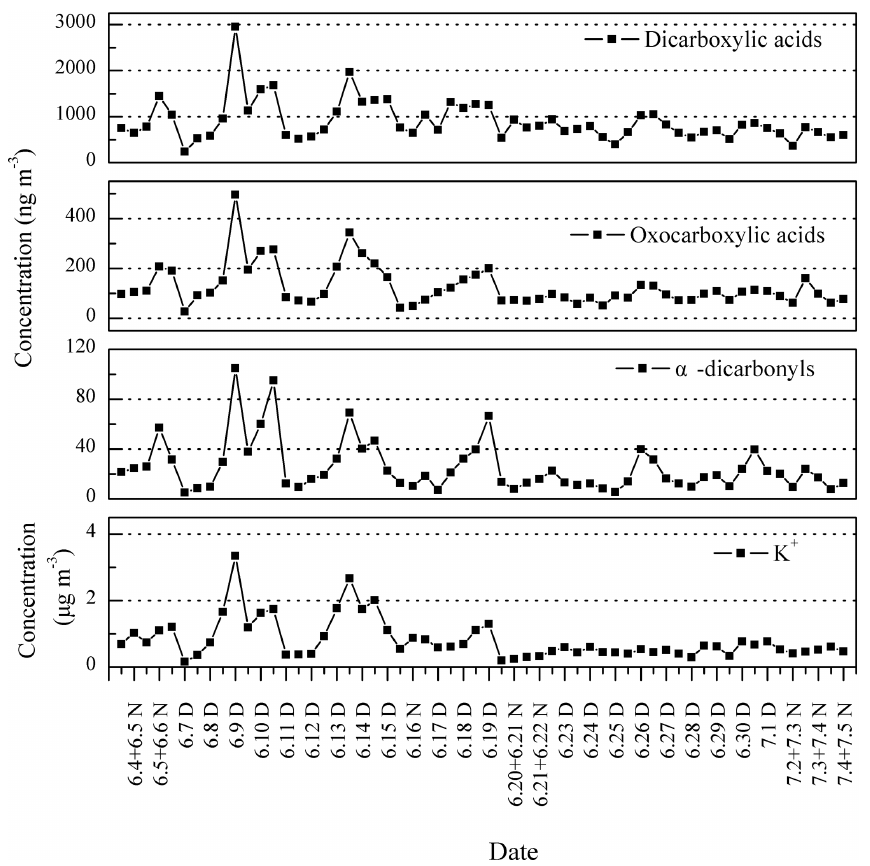
Figure 8. Temporal variation of DCRCs and K + in PM 2 . 5 aerosols collected at Mt. Tai during the day (D) and night (N) in 2014.